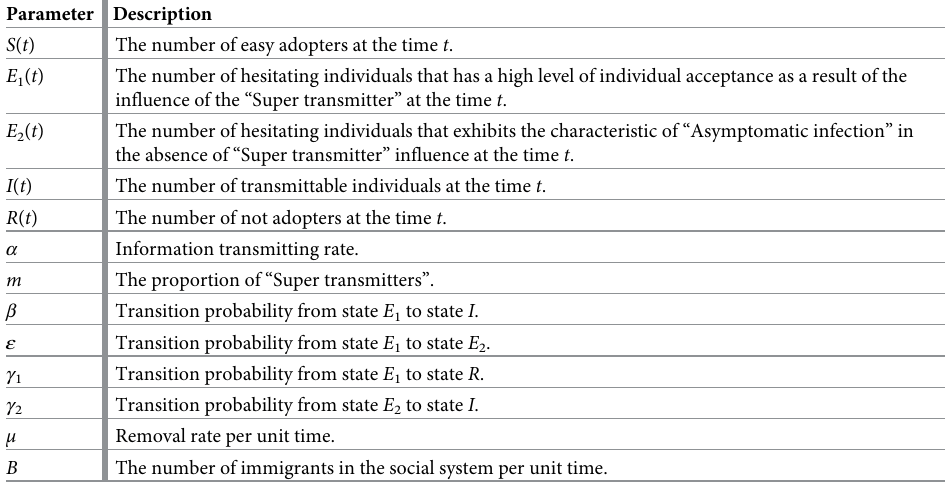
Table 1. The parameter description of S2EIR